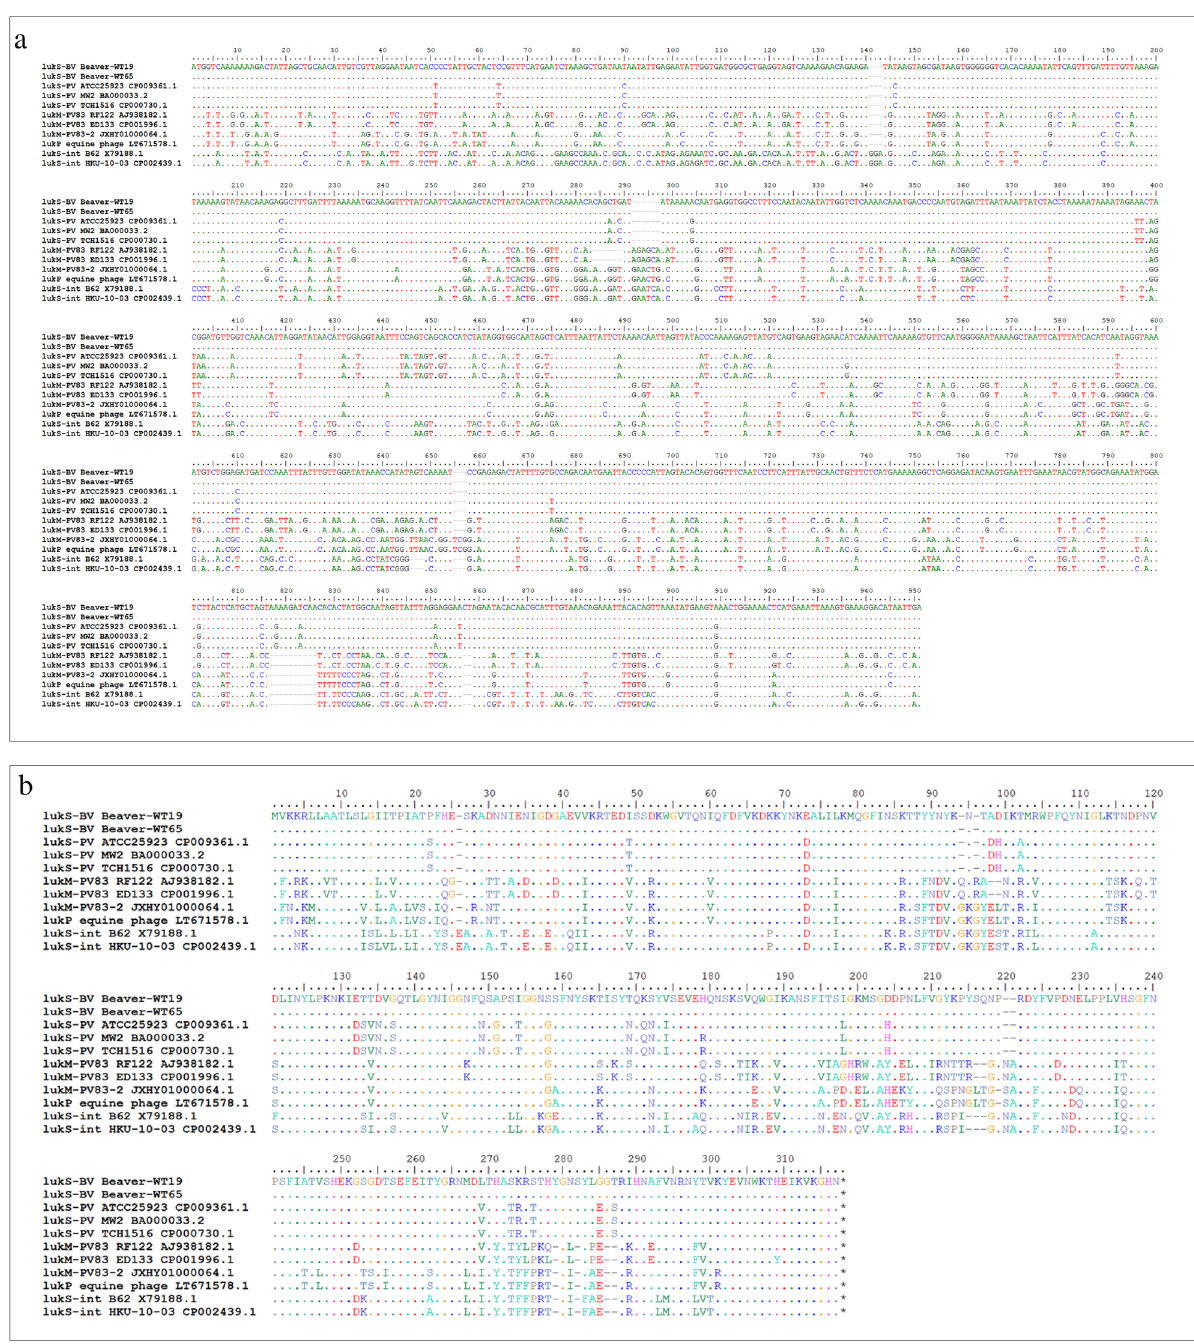
Figure 3. ( a ) Alignment of the lukS- BV sequences, of other phage-borne leukocidin S component sequences from S. aureus and of lukS -int from S. intermedius/pseudintermedius. ( b ) Alignment of the amino acid sequences of the corresponding lukS gene